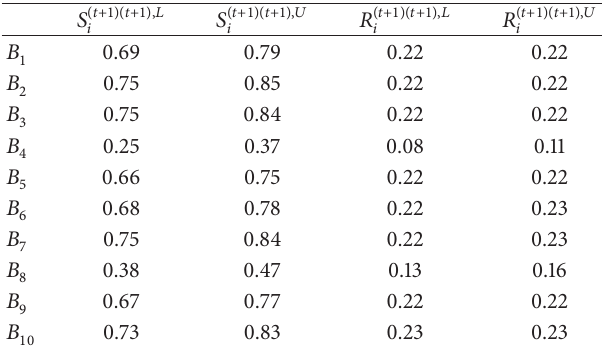
Table 13: 𝑆 and 𝑅 interval numbers (year of 2005-year of